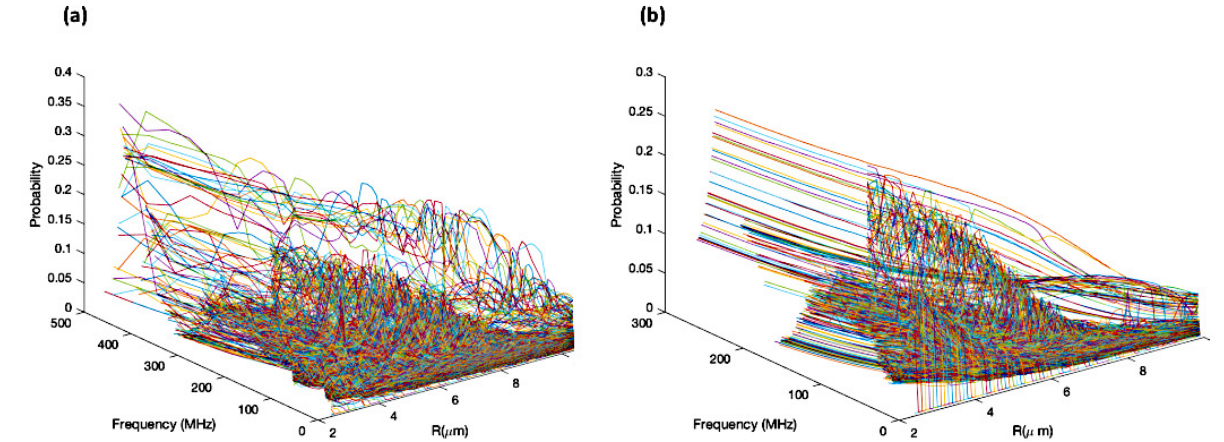
Figure 5. ( a ) The probabilities as a function of the frequency shift and the internuclear spacing R in the states calculated in the hexagon configuration shown in Figure 2a. ( b ) The probabilities as a function of the frequency shift and the internuclear spacing R in the states calculated in the Octahedron configuration shown in Figure